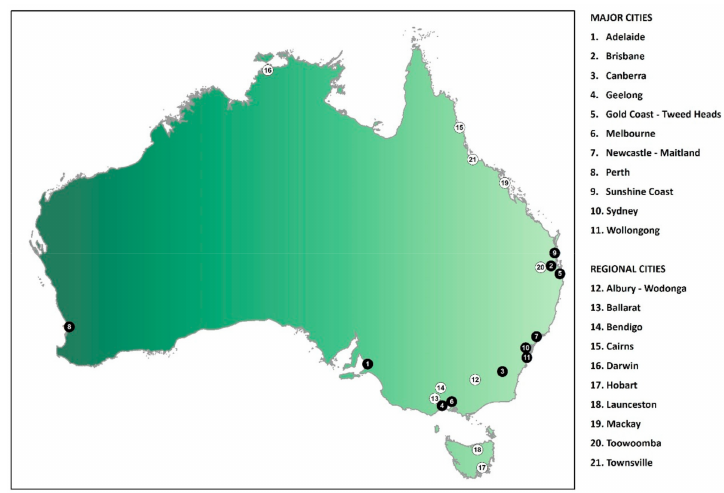
Figure 1. Map of Australia showing the location of the 11 major cities and 10 regional cities included in the